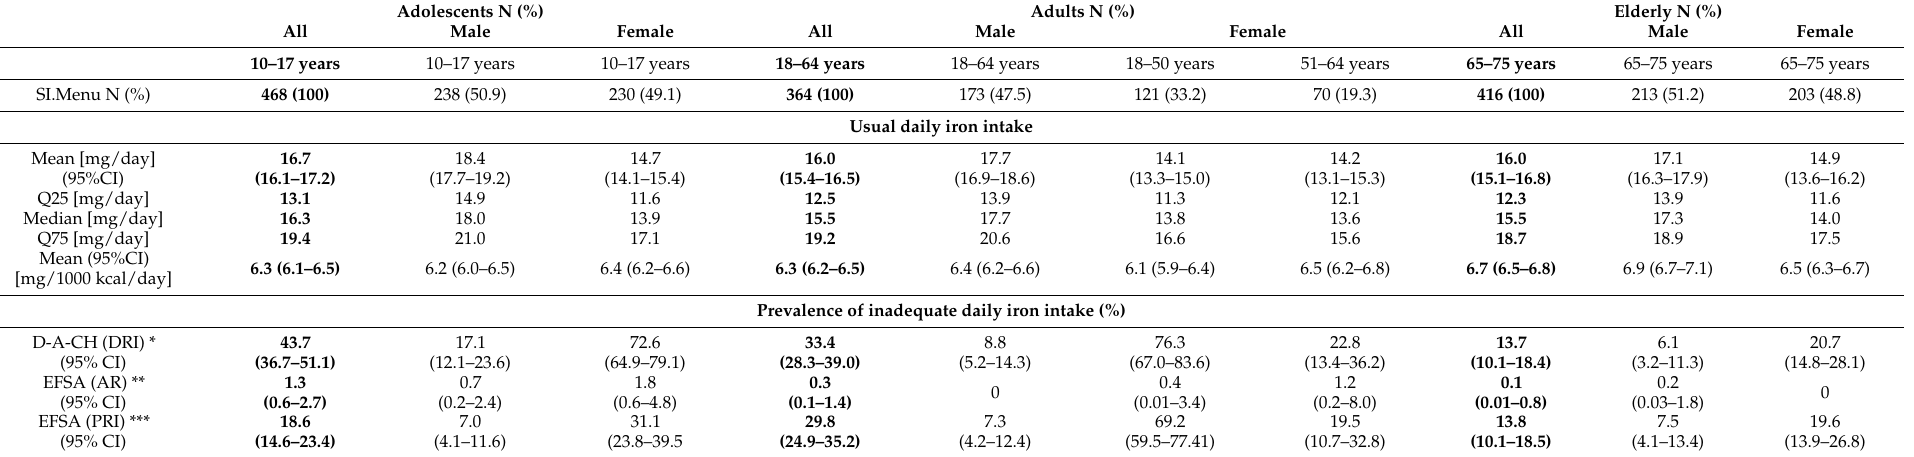
Table 1. Population-weighted usual daily dietary iron intake and the prevalence of inadequate daily dietary iron intake (95% CI) according to D-A-CH (DRI) and EFSA (PRI, AR) recommendations.